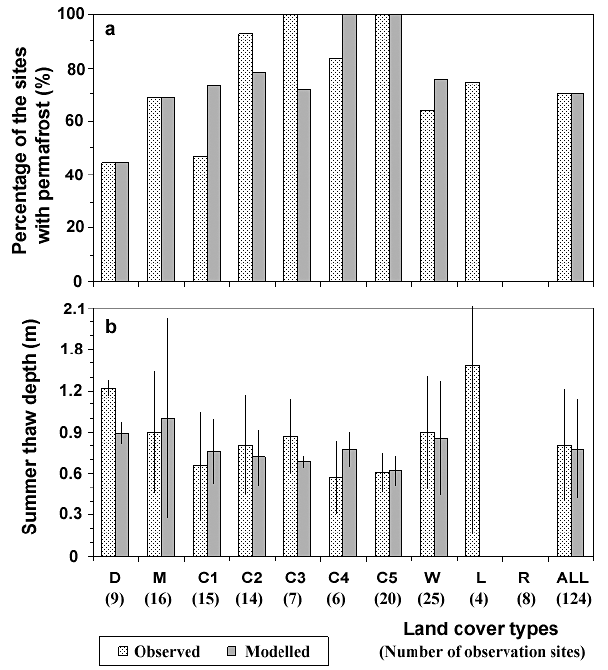
Figure 8. Comparisons of observed and modelled (a) percentage of the sites with permafrost and (b) the average and standard deviation of summer thaw depths for each land cover type. The numbers in brackets below the x axis are the numbers of observation sites. The average or the standard deviation of summer thaw depths were cal- culated based on the sites with permafrost (observed or modelled). The land cover types S, SH, and H were not shown because there were no field observations for in the study area for these three types.